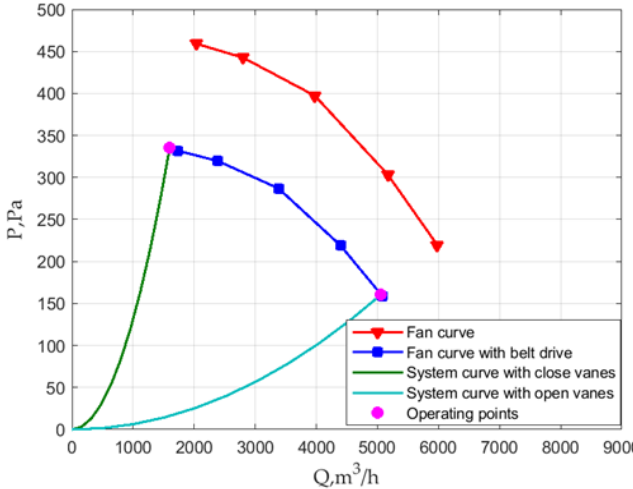
Figure 6. Flow–pressure curves of the fan with and without belt drive, as well as the duct curves with open and closed inlet vanes. Table 1. LSPMSM parameters.